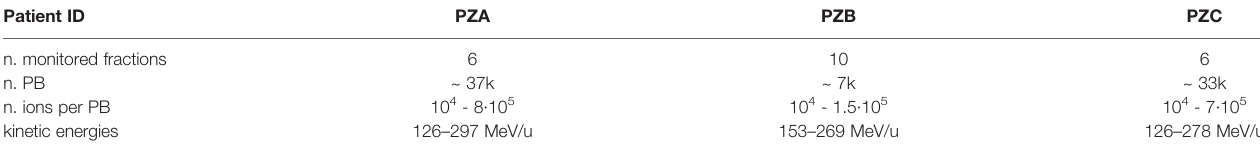
TABLE 1 | Details of the treatment plans delivered to the patients considered in this paper. Patient ID PZA PZB PZC n. monitored